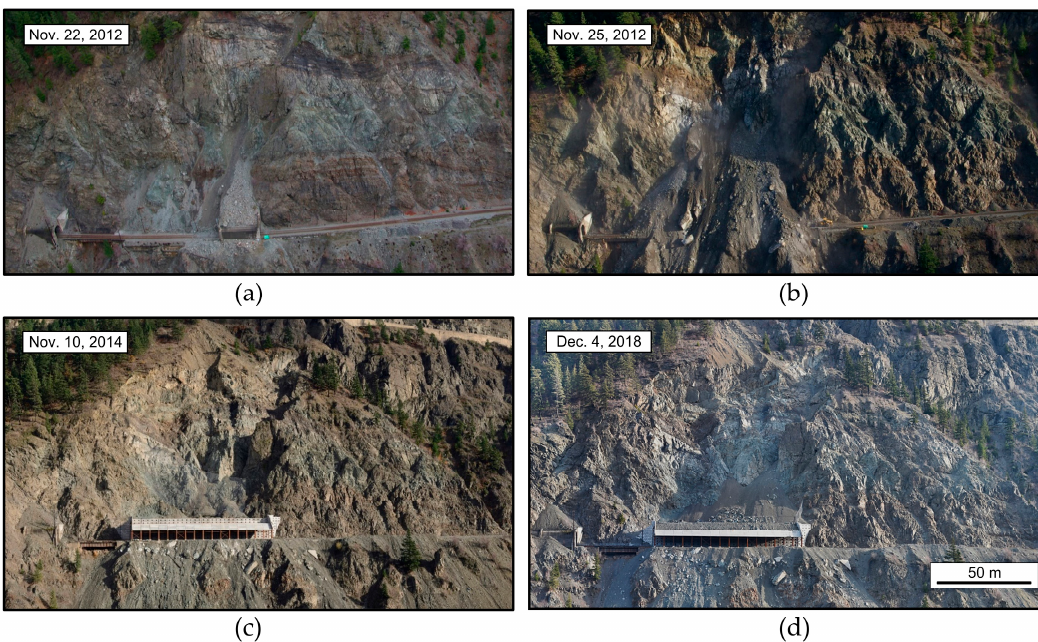
Figure 4. A stereonet plot of the four major joint sets present at CN Ashcroft Mile 109.4. Modified from Sturzenegger et al. [50].